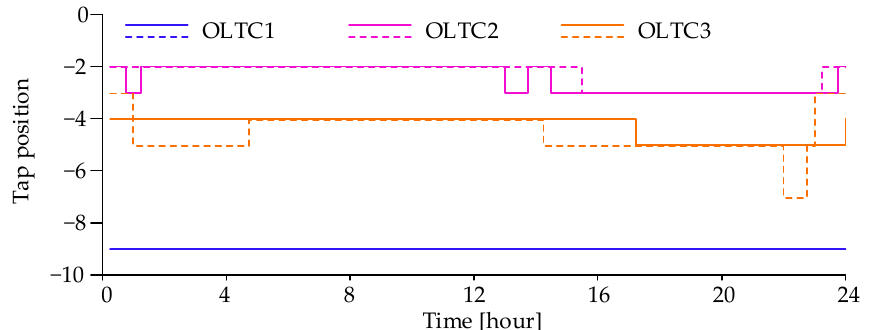
Figure 4. Day-ahead operating scheme of OLTCs.